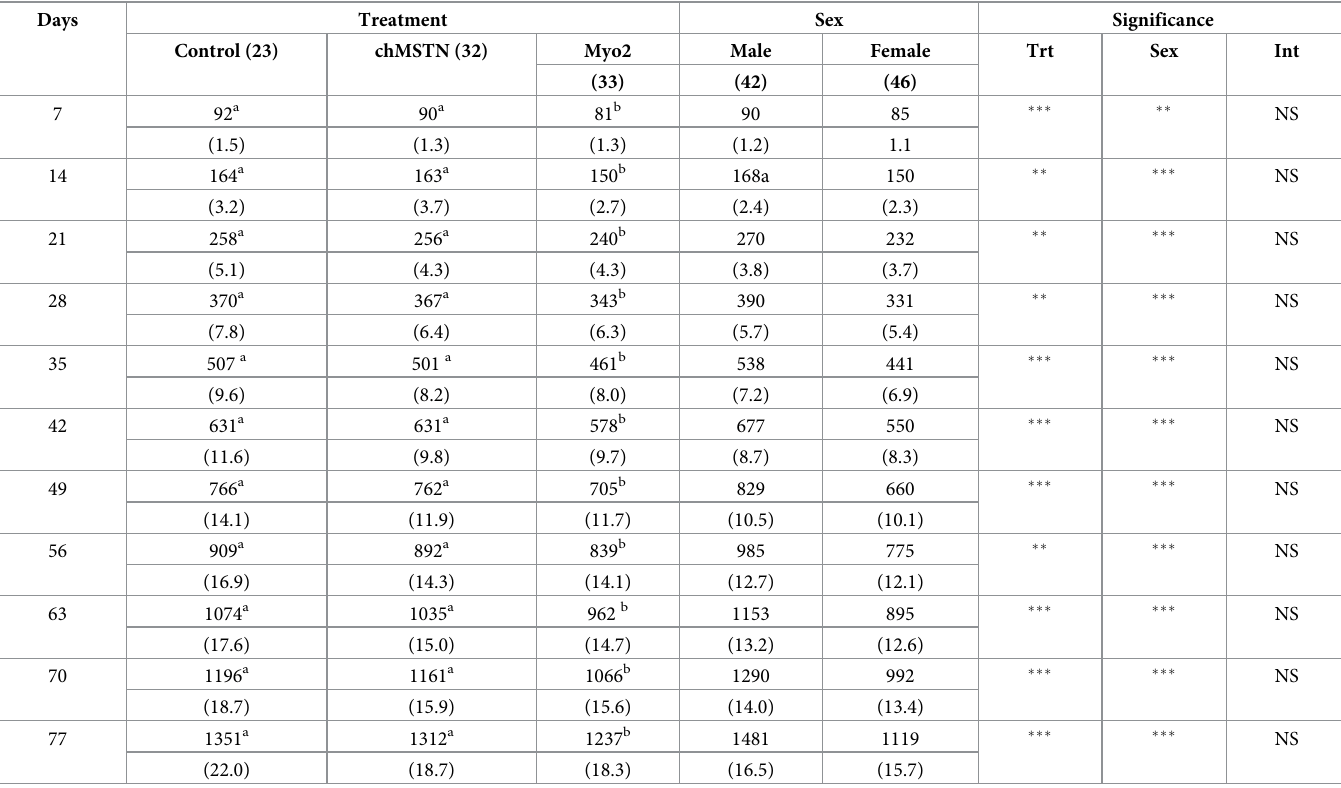
Table 3. Bodyweights of chicks from the Control, chMSTN, and Myo2 groups in Experiment 2. Days Treatment